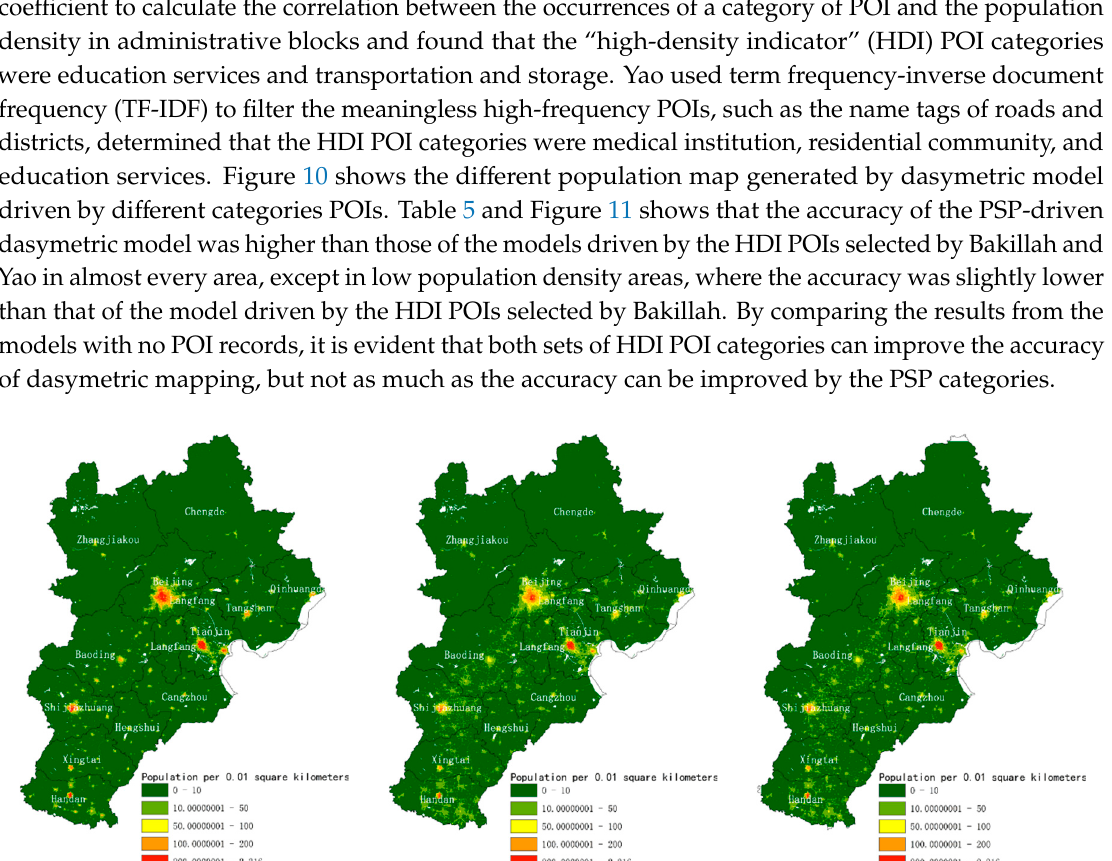
select by others ( a ) PSP ( b ) Bakillah ( c ) Yao.